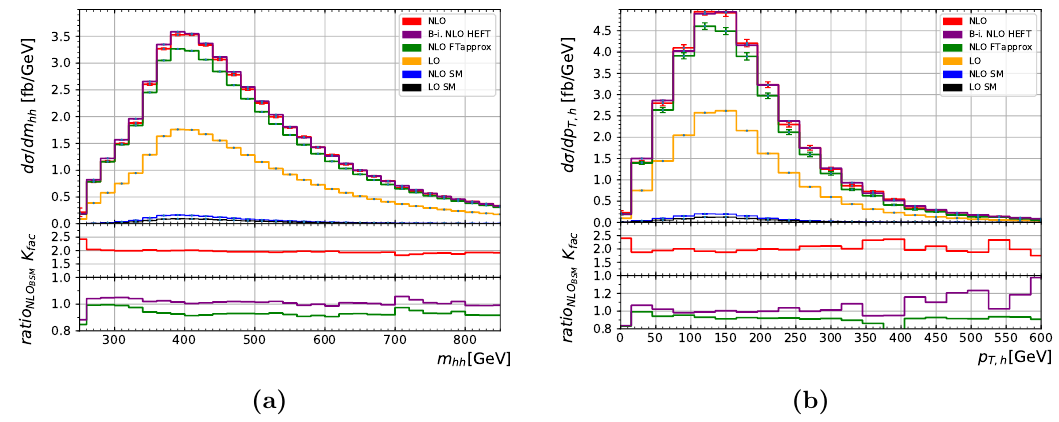
Figure 14. Same as (cid:12)gure 12 but for benchmark point 3, c hhh = 1 ; c t = 1 ; c tt = (cid:0) 1 : 5 ; c ggh = 0 ; c gghh = 4 = 15.